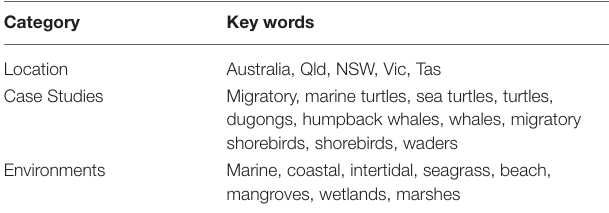
TABLE 2 | Key words used to collate environmental policies and management plans in Australia related to four taxa of marine migratory species.